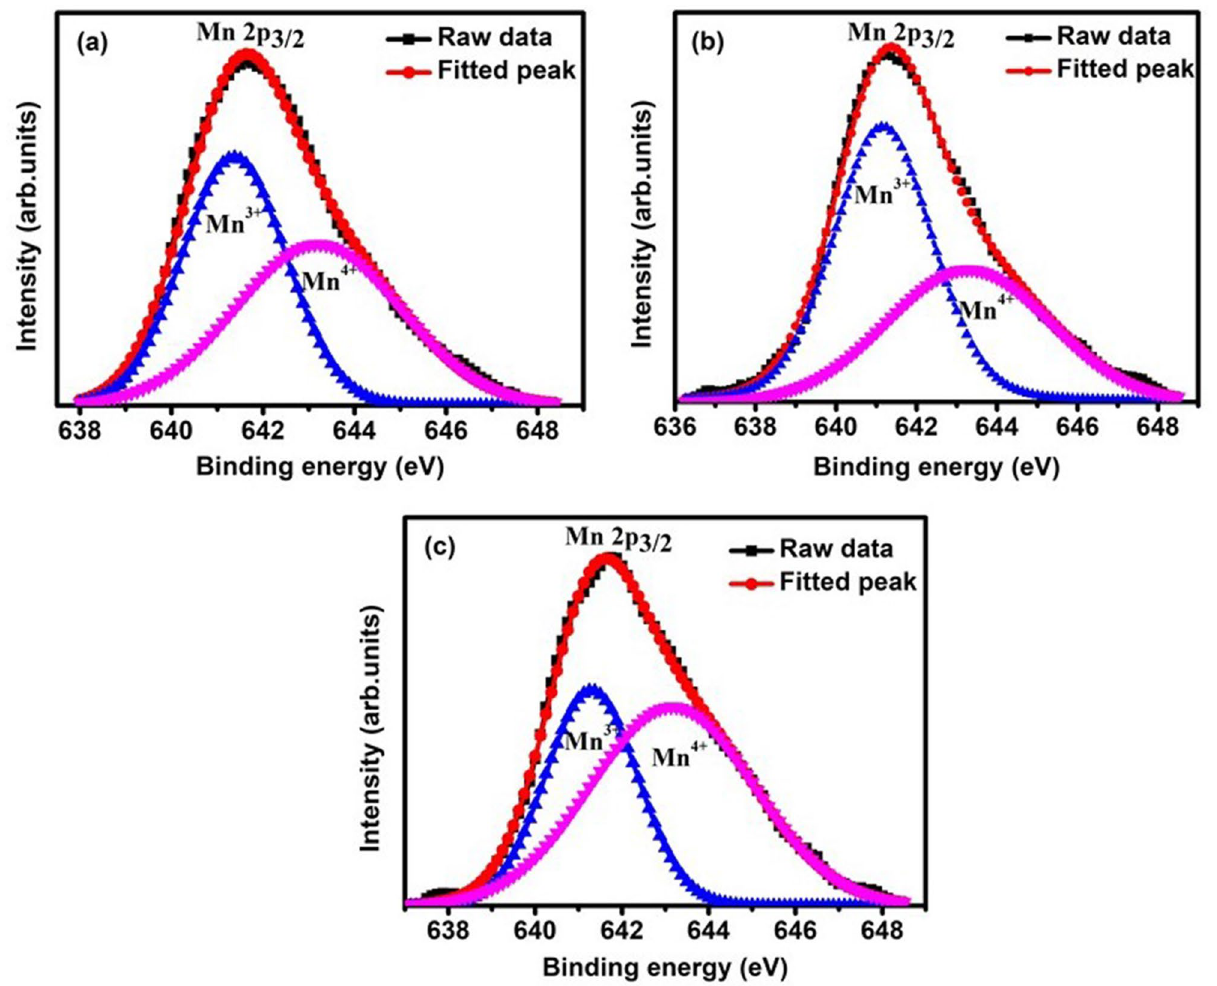
Figure 2. High-resolution XPS spectra of Mn2p for ( a ) ENMO, ( b ) GNMO, ( c ) TNMO